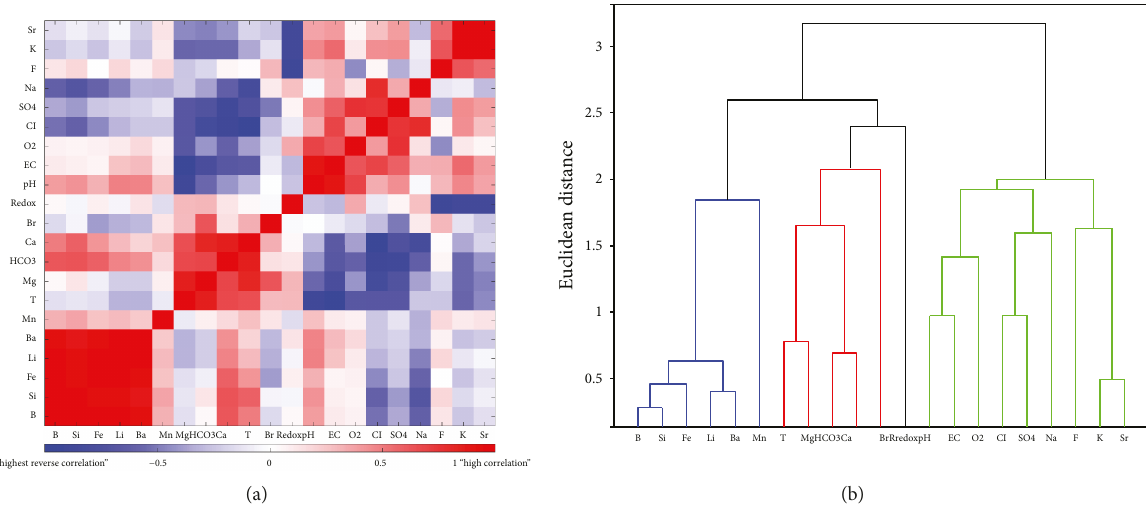
Figure 5: (a) Correlation of chemical elements in the geothermal fl uid ( − 1: highest reverse correlation, 0: no correlation, and 1: highest correlation); (b) strength of correlation shown by subgrouping of chemical elements using cluster analysis based on cross-correlation- derived Euclidian distances. EC: electrical conductivity. Table 2: Results of hydrochemical modeling. Saturation index shows the possibility of precipitation of indicated minerals in the respective scenario (2P: production site, 1I: injection site, and equ.: equilibrium). Supersaturated minerals 2P in equ. with rock 1I in equ. with